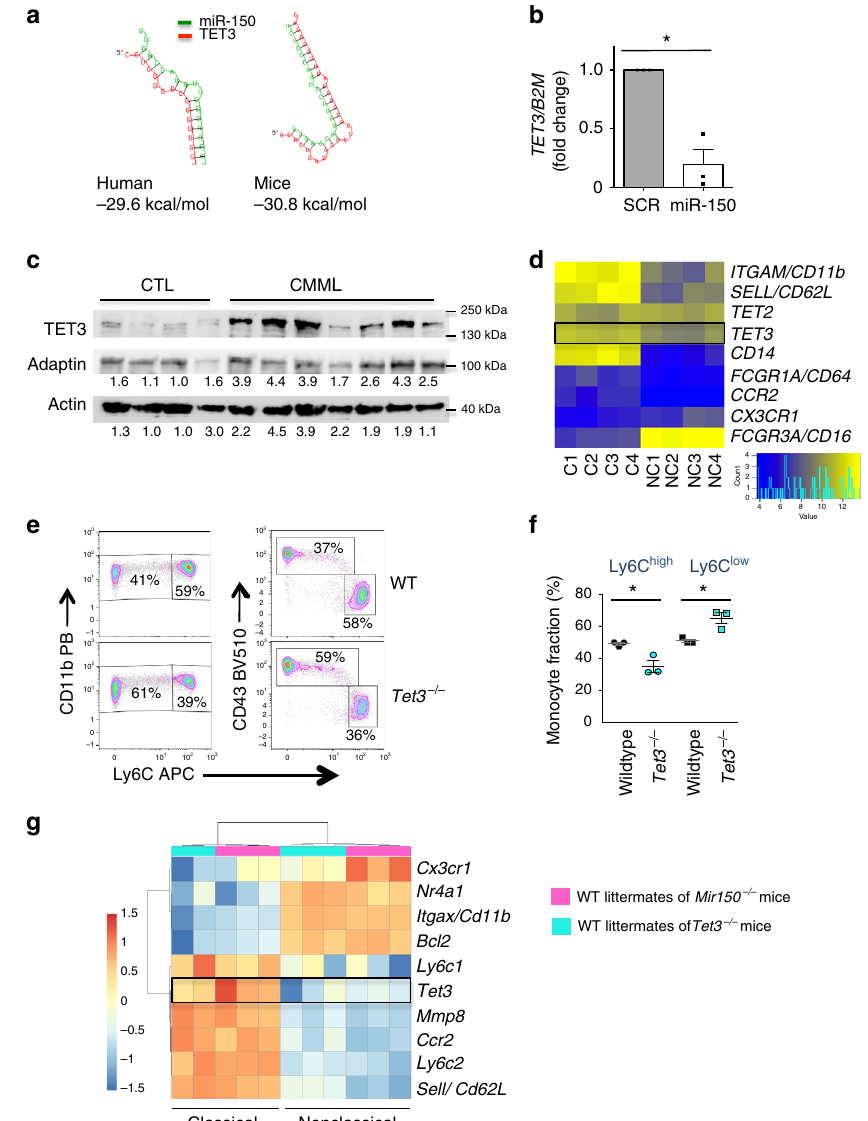
Fig. 8 TET3 is a miR-150 target involved in monocyte subset differentiation. a Hybridization analysis of 3 ′ -UTR of TET3 with mature sequences of miR-150 using RNA-hybrid software in human and mouse. Structures with minimum free energy are shown. b Expression of TET3 (normalized to B2M) in monocytes generated by culture of human CD34 + cells transduced with hsa-miR-150-GFP compared to control-transduced cells (SCR). Results are expressed as TET3 expression fold-change in hsa-miR-150-overexpressing cells relative to control (SCR, normalized to 1). Mean ± SEM of three independent experiments. Paired t test, * P < 0.05. c Immunoblot analysis of TET3 expression in four healthy donor (CTL) and seven CMML patient monocytes. ADAPTIN and ACTIN are the loading controls. TET3/ADAPTIN or TET3/ACTIN ratio are shown below. Blots have been cropped for clarity. d Heat map of TET2 and TET3